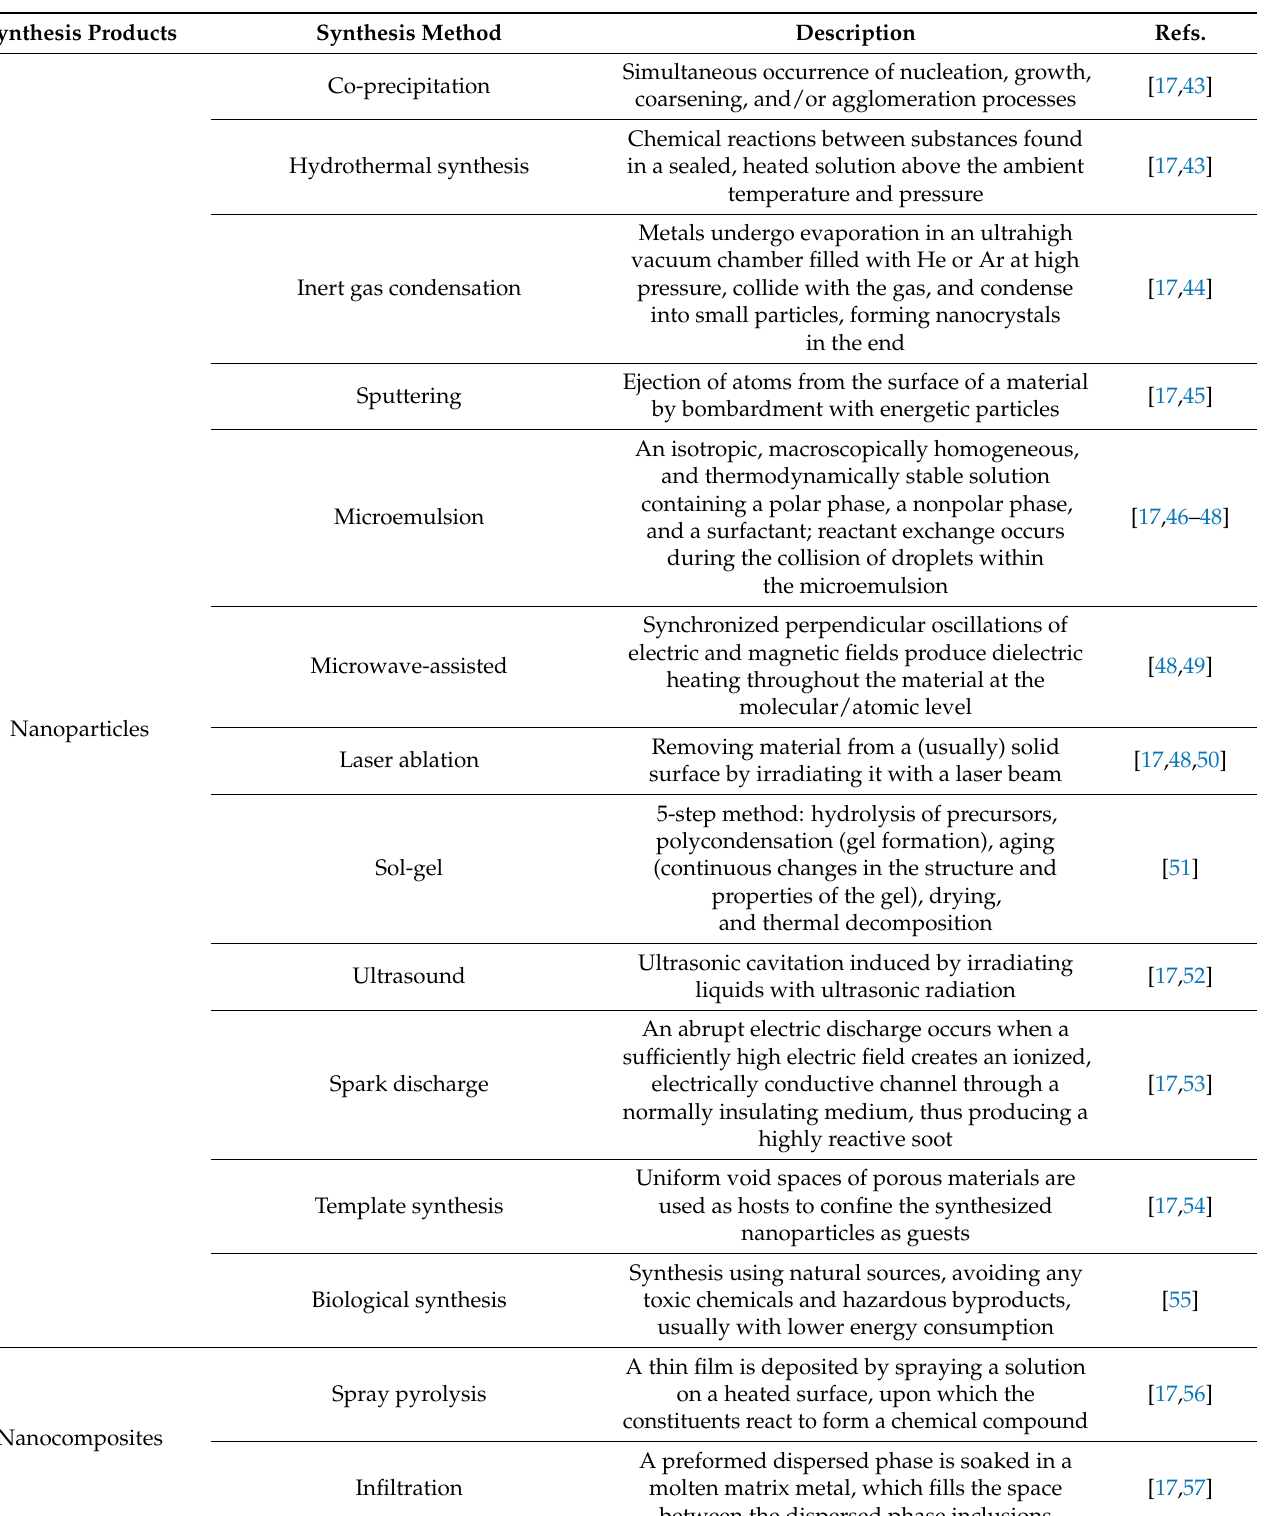
Table 1. Conventional methods for the synthesis of nanoparticles and